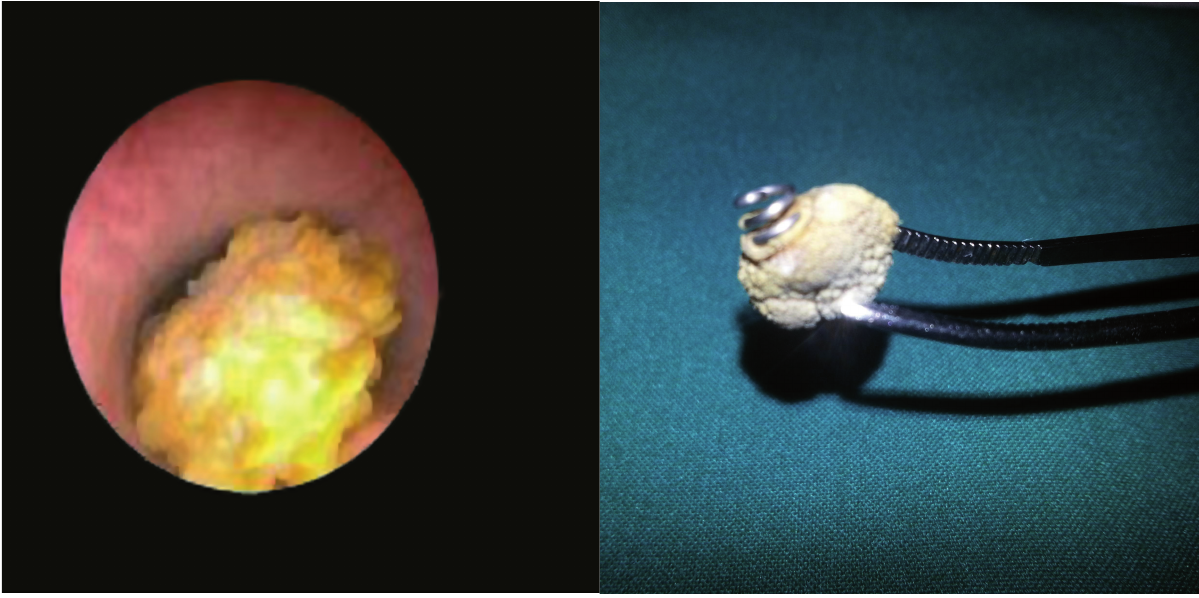
Figure 2 - Migrated tacker adhered on the bladder wall at cystoscopy and post-surgery